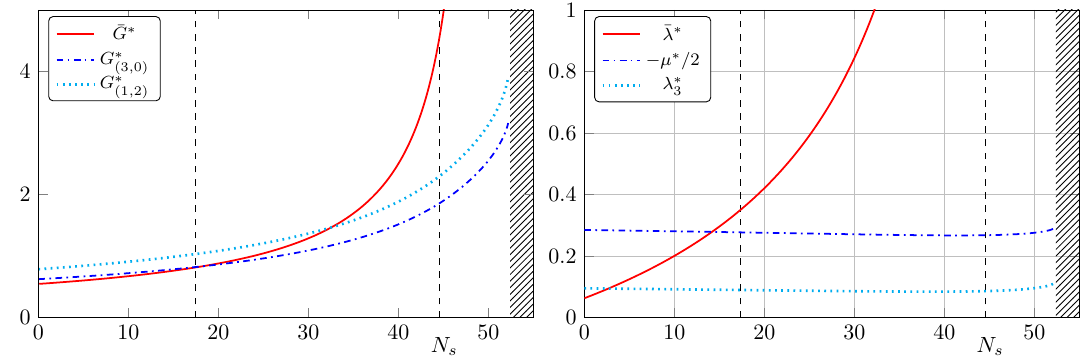
Figure 6: Displayed are the fixed-point values as a function of N . We use the fluctu- s ation system as input on the right-hand side of the Wetterich equation. Left: Fixed- point values of background and fluctuation Newton couplings. Right: Fixed-point values of background and fluctuation cosmological constant. The vertical lines at ≈ 17.5 and N ≈ 44.6 show where η ( 0 ) and η ( k 2 ) exceed two, respectively. N s s h h field anomalous dimensions on the right-hand side of the Wetterich equation, evaluated at G ∗ , G ∗ , µ ∗ and λ ∗ ( 3,0 ) ( 1,2 ) 3